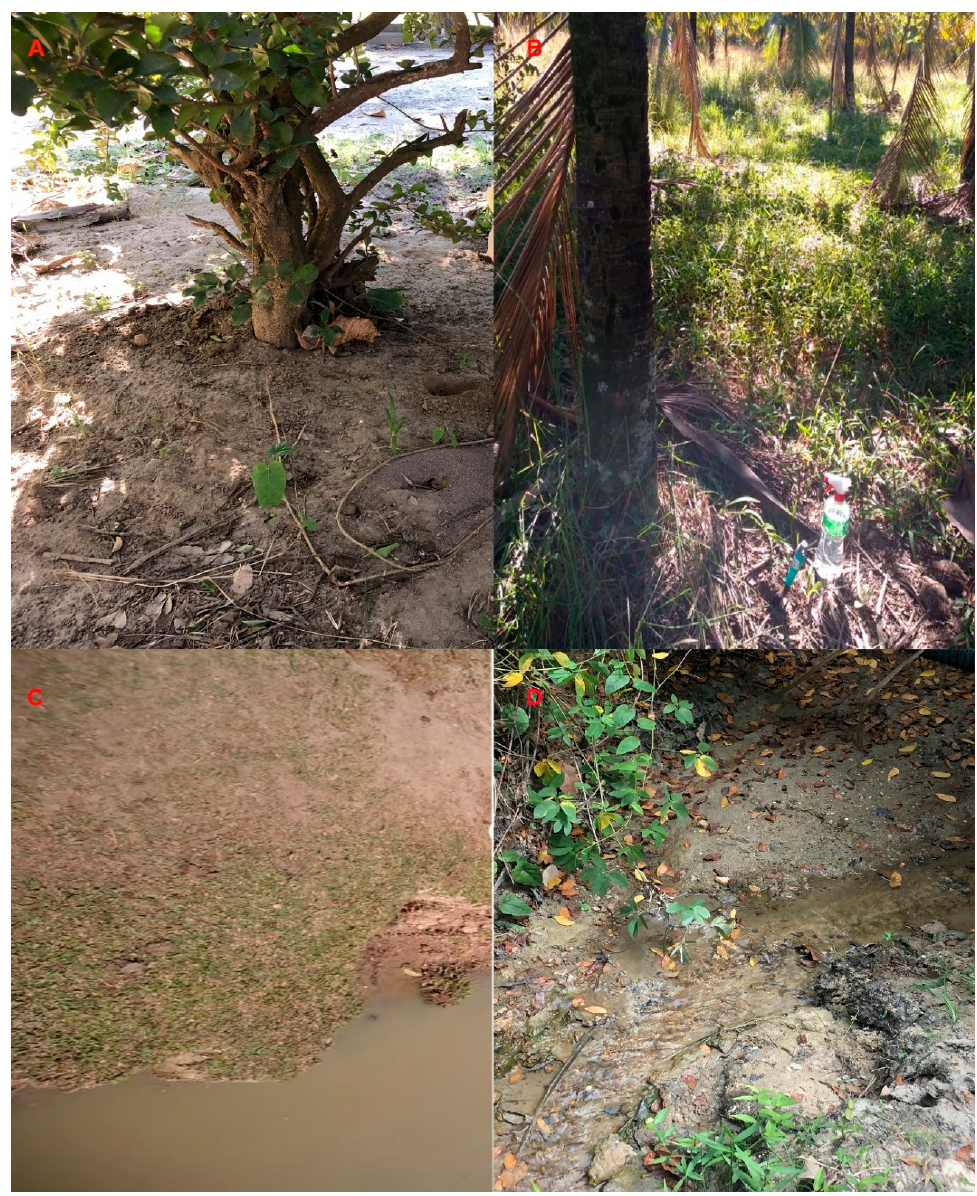
Figure 4. Soil samples with Sporothrix brasiliensis DNA detection. ( A ) Soil around an acerola fruit tree ( Malpighia emarginata ). ( B ) Soil around a coconut tree ( Cocos nucifera ) enriched with cow dung. ( C ) Soil around an artificial lake. ( D ) Soil from the bottom of a stream. Sites A to C are located in Serop é dica. Site D is located in Nova Iguaç ú